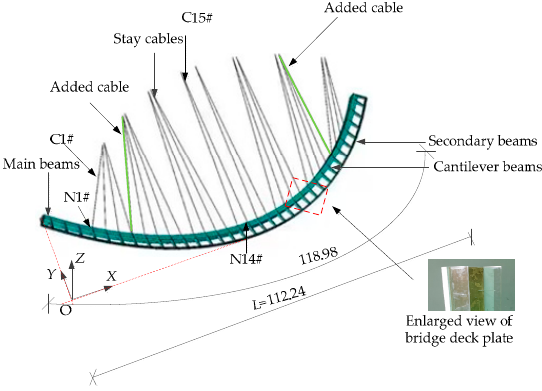
Figure 1. Diagram of the curved beam unilateral stayed bridge (Unit: m).